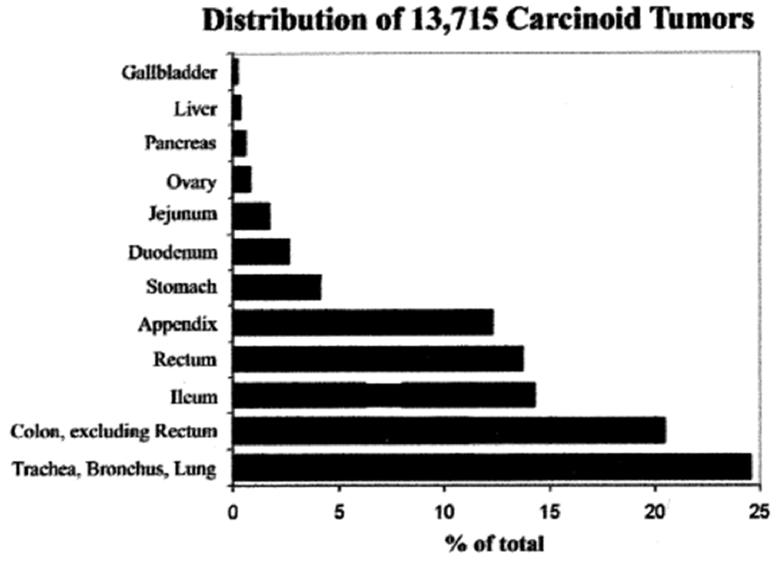
Figure 1. Sites of carcinoid tumors in the USA between 1950 and 1999 [6].